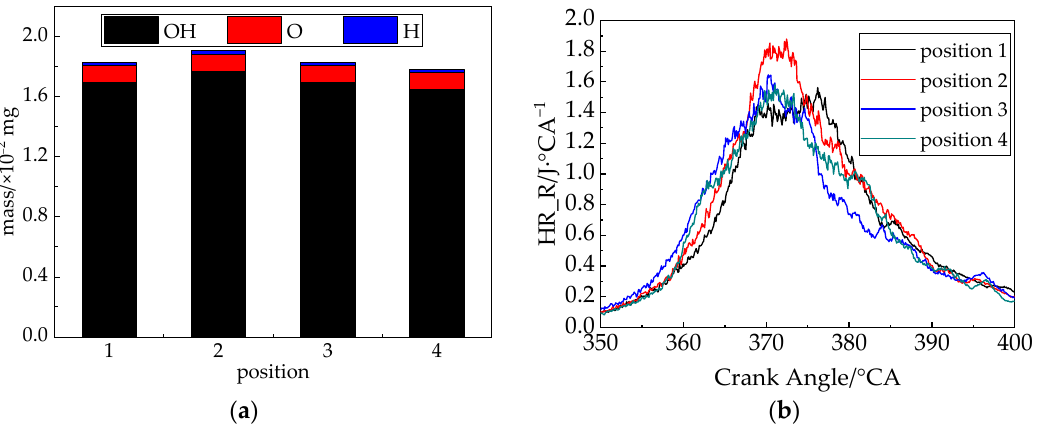
Figure 10. Comparison of parameters at different positions: ( a ) sum of peak mass of OH, O and H radicals, ( b ) heat release rate (HRR).